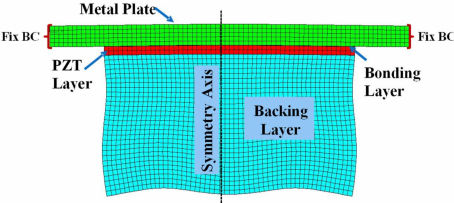
Figure 4. A 2D axisymmetric finite element analysis (FEA) model of the piezoelectric multilayered structure and its deformed